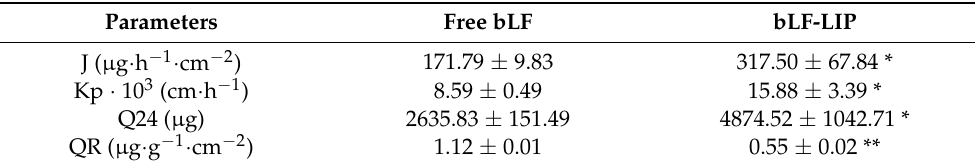
Table 4. Pharmacokinetic parameters adjusted to linear regression of the ex vivo corneal permeation of bLF-LIP against bLF.